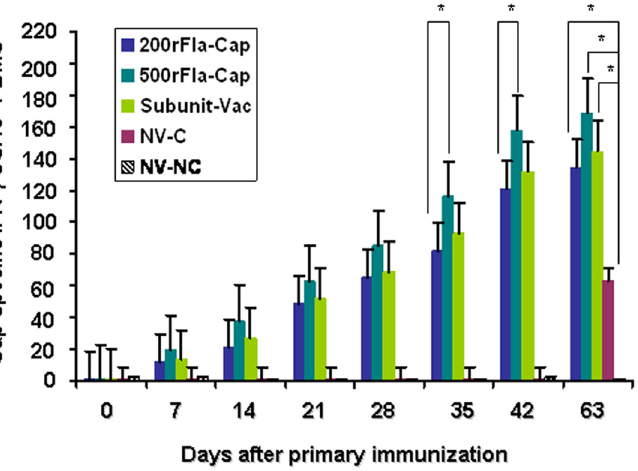
Fig 3. Mean frequencies of Cap-specific interferon- γ -secreting cells (IFN- γ -SC) per million of PBMC were determined after vaccination and PCV2 challenge. Results indicate mean Cap-specific IFN- γ -SC frequencies of each group samples ± SD from one of two independent experiments. p < 0.05 ( * ) represents significant difference between 500rFla-Cap and 200rFla-Cap-vaccinated pigs at the indicated times after vaccination, or vaccinated and non-vaccinated pigs after PCV2 challenge (day